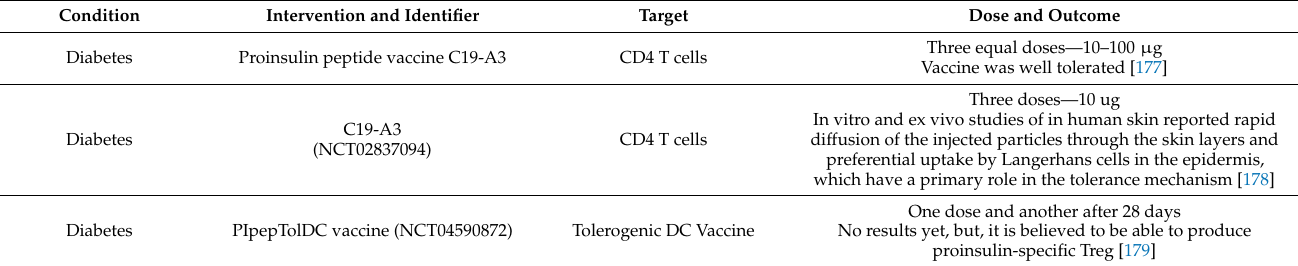
Table 3. Intradermal administration as treatment for diabetes.